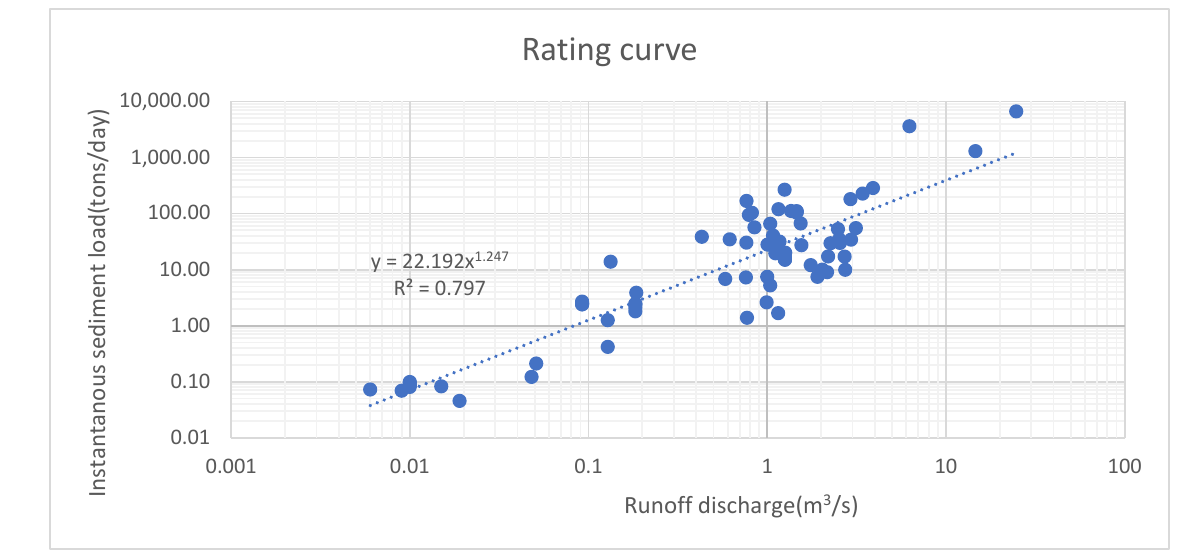
Figure 7. Rating curve for the Angereb sub-watershed.